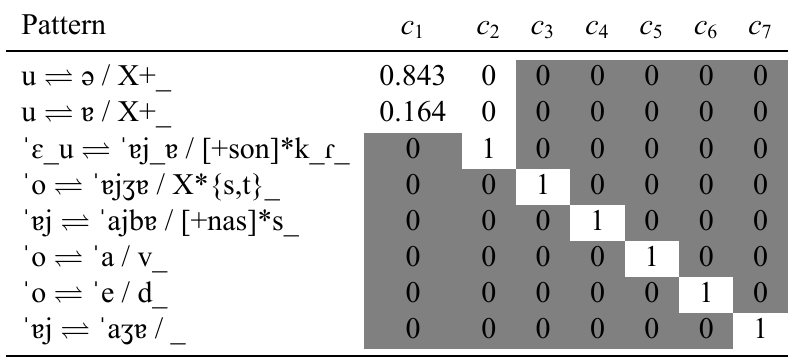
Table 13: Conditional probability of each pattern relating PRS.IND.1SG to PRS.SBJV.1SG , given the category of the PRS.IND.1SG